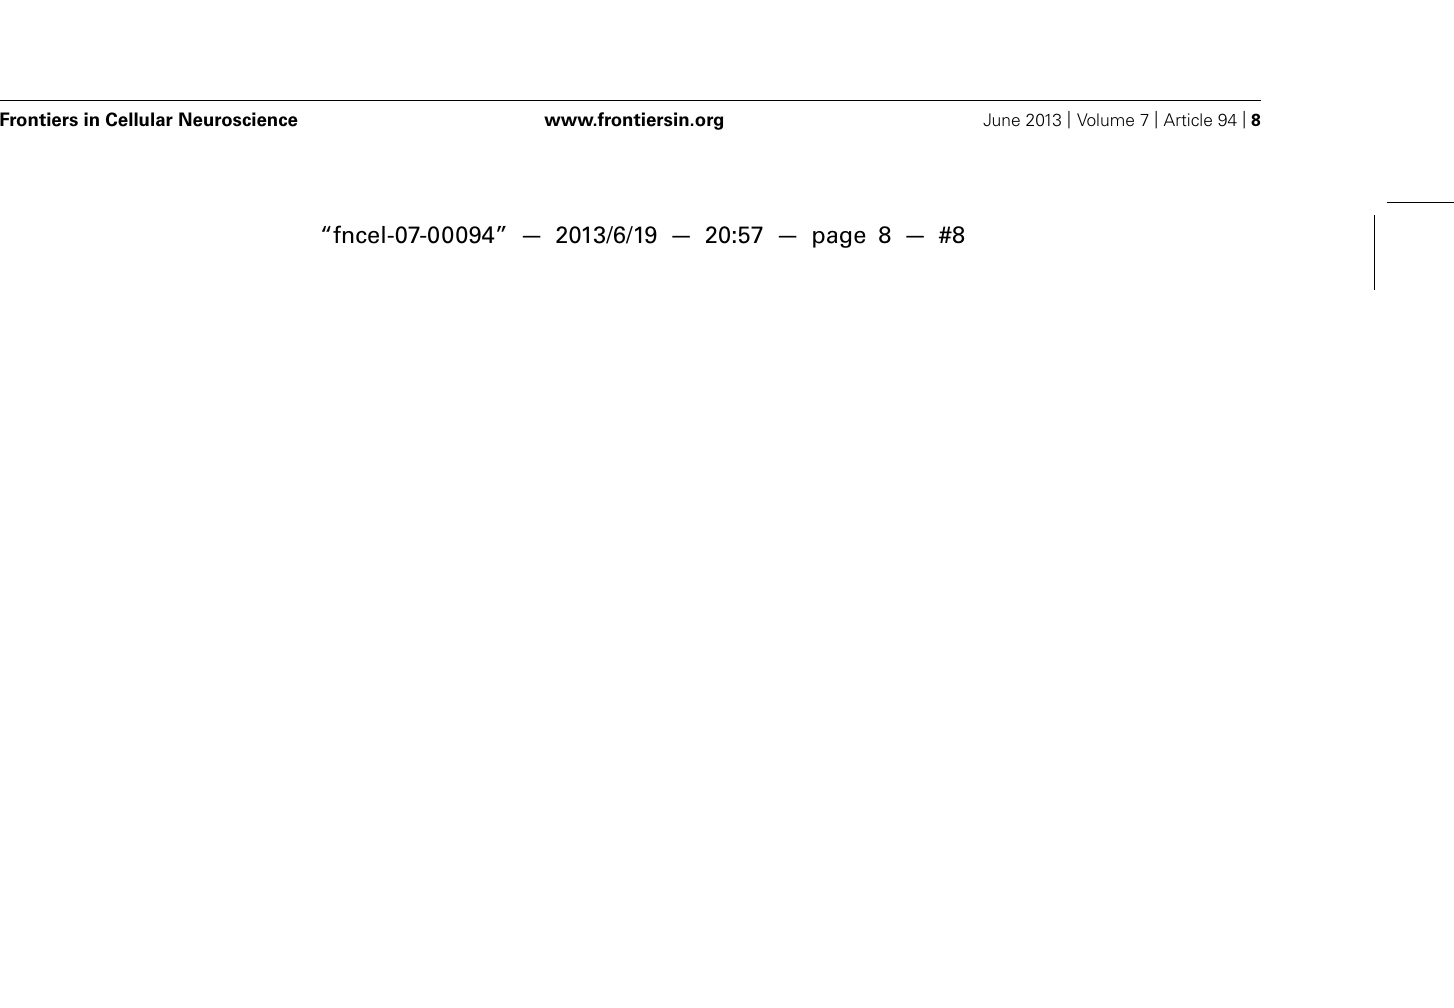
FIGURE 2 | sAPP α as a network activator in anabolic etiology of autism. The sAPP α product has multiple functions that can contribute to neuronal overgrowth and increase risk of autism. Specifically, sAPP α , produced by α -secretase activity of proteins such as ADAM17, acts on its own as a cell growth factor, stimulates neuronal migration, induces synaptogenesis, and promotes cellular adhesion, all of which lead to neuroproliferation. In addition, sAPP α activates ERK and Akt, which in turn also lead to neuroproliferation. (A) Under normal development, these processes result in normal